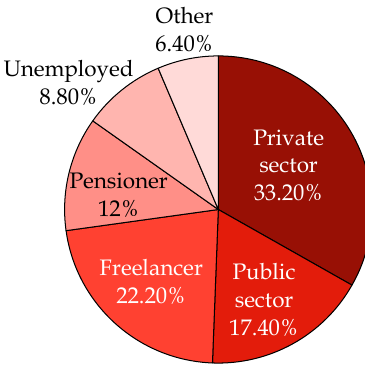
Figure 2. Occupation of the participants.